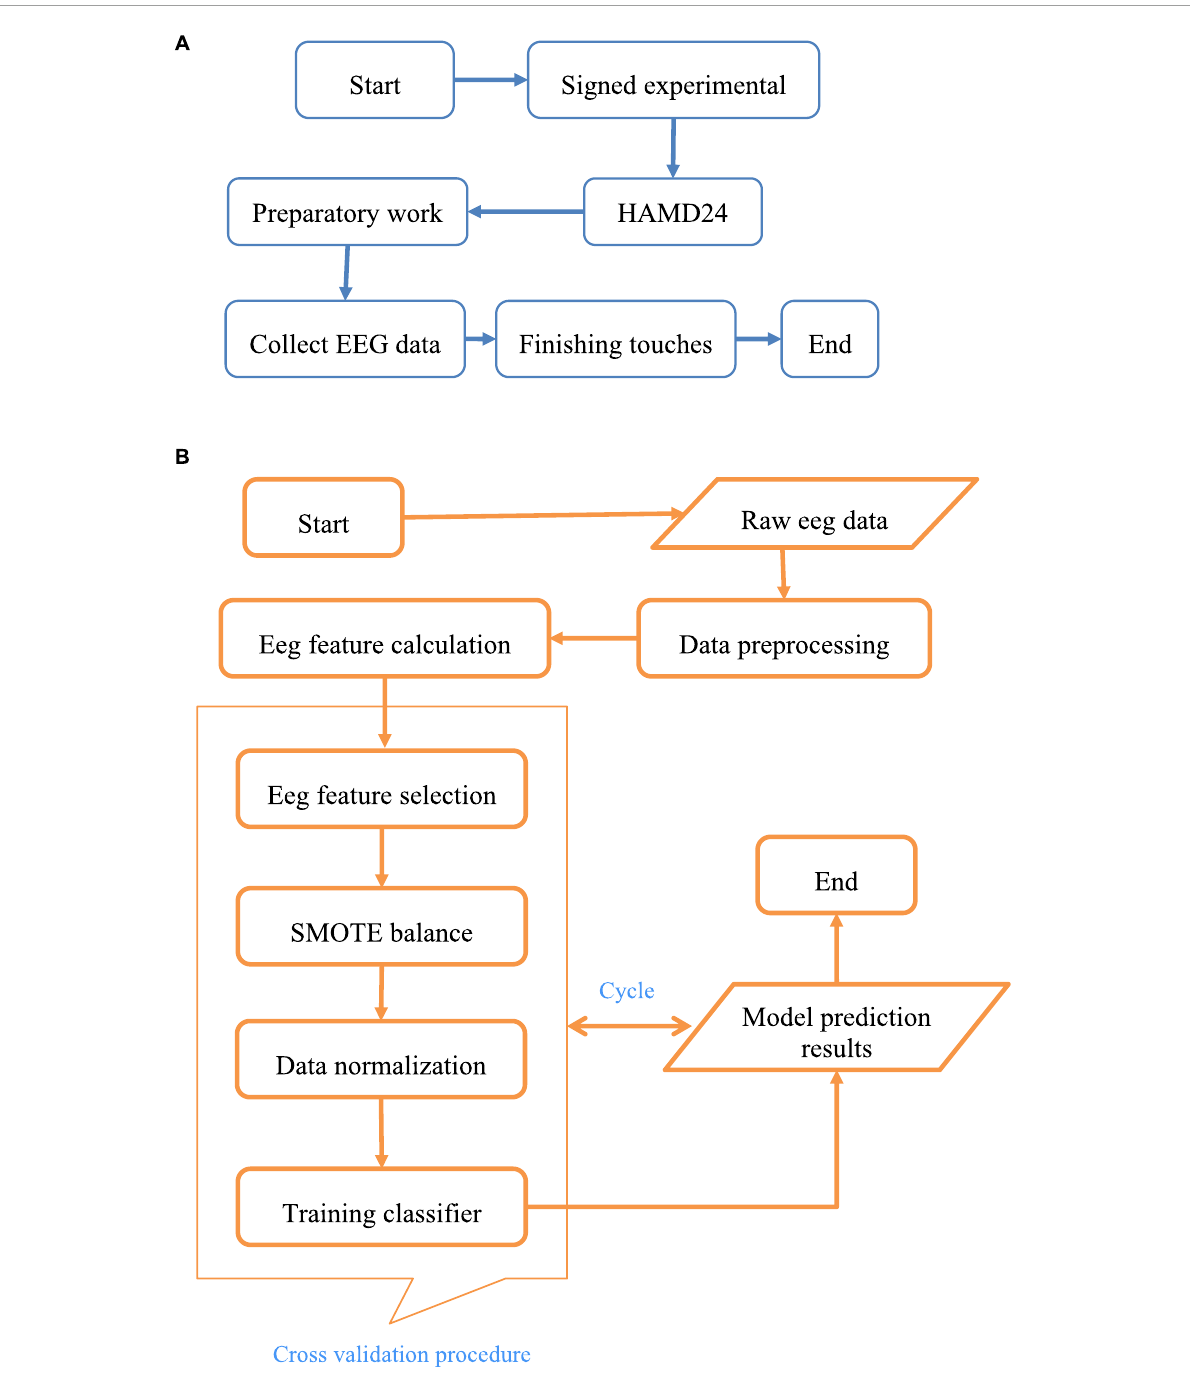
FIGURE1 The process of EEG data collection and identification for depression. Among them, (A) was the flow chart of EEG acquisition, and (B) showed the experimental research flow of the depression recognition model.